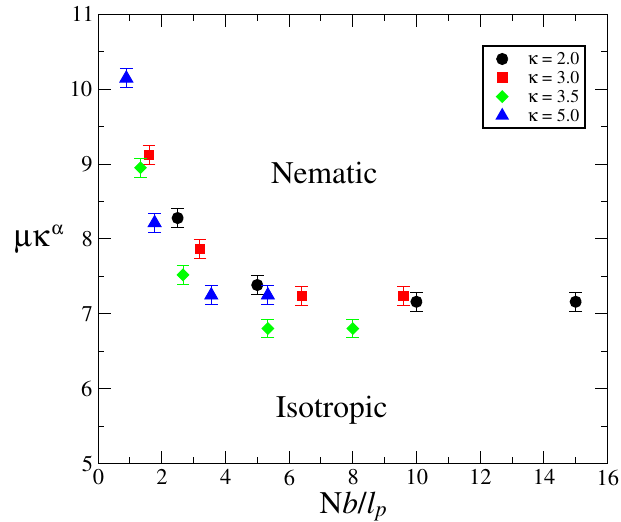
Figure 4. Phase diagrams in Figure 2 in terms of the renormalized parameters µκ α and Nb / (cid:96) p